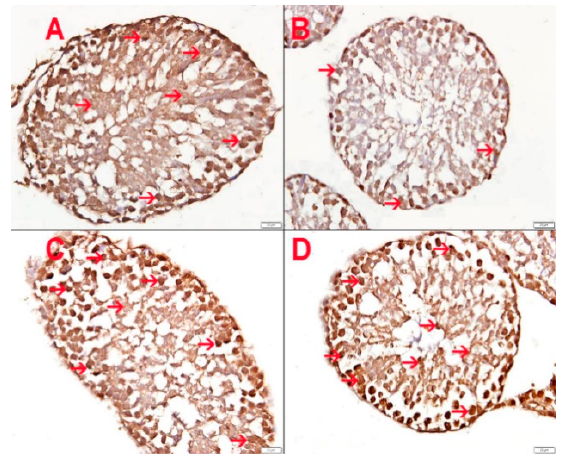
Figure 7. Showing superoxide dismutase (SOD) expression in germ cells within seminiferous tubules.